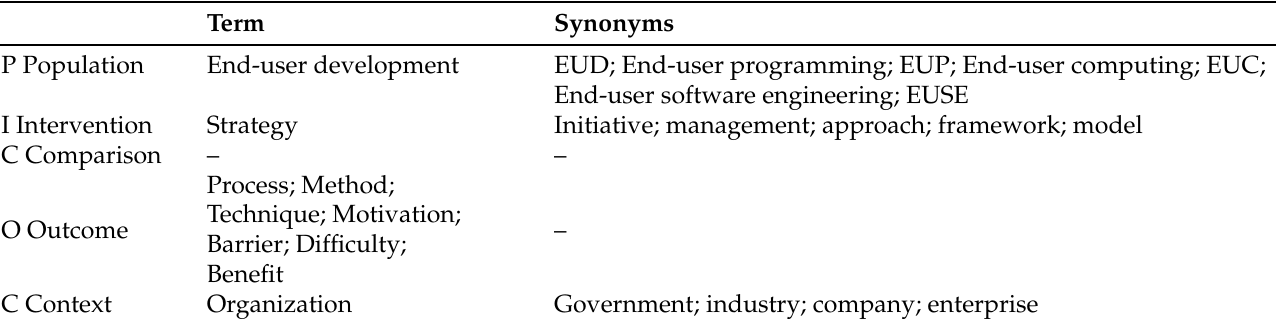
Table 1. The Population, Intervention, Comparison, Outcomes, and Context (PICOC) approach. Term Synonyms P Population End-user development EUD; End-user programming; EUP; End-user computing; EUC; End-user software engineering;